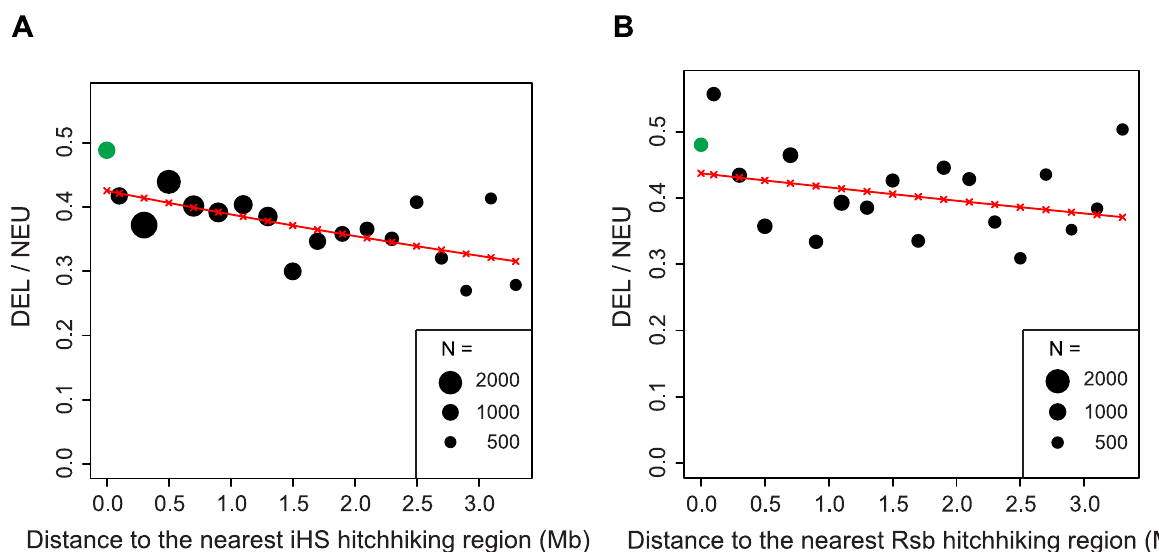
Figure 4. The ratio of deleterious to neutral nonsynonymous SNPs declines as a function of distance to the nearest hitchhiking region. Hitchhiking regions were defined using the European population by iHS (A) or Rsb (B). Sample size is indicated by circle size. Green circles represent iHS and Rsb hitchhiking regions.